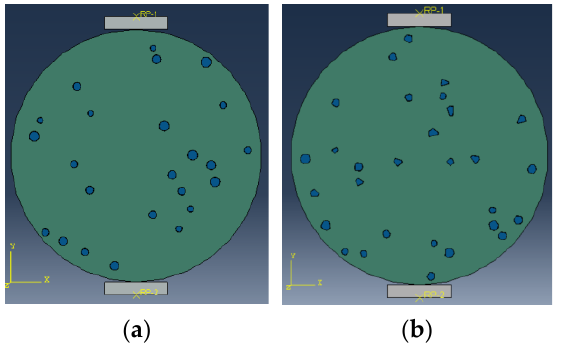
Figure 6. CRM specimens for indirect tensile test. ( a ) CRM 6 with circular rubber particles. ( b ) CRM 6 with circle-derived polygonal rubber particles.